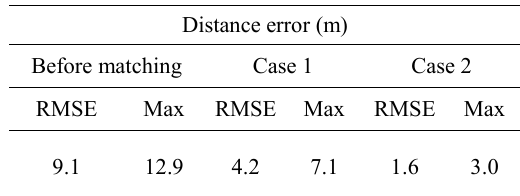
Figure 9. Visualization of the distances between 505 ICESat points (red circles) and the surface points (blue triangles) Distance error (m)